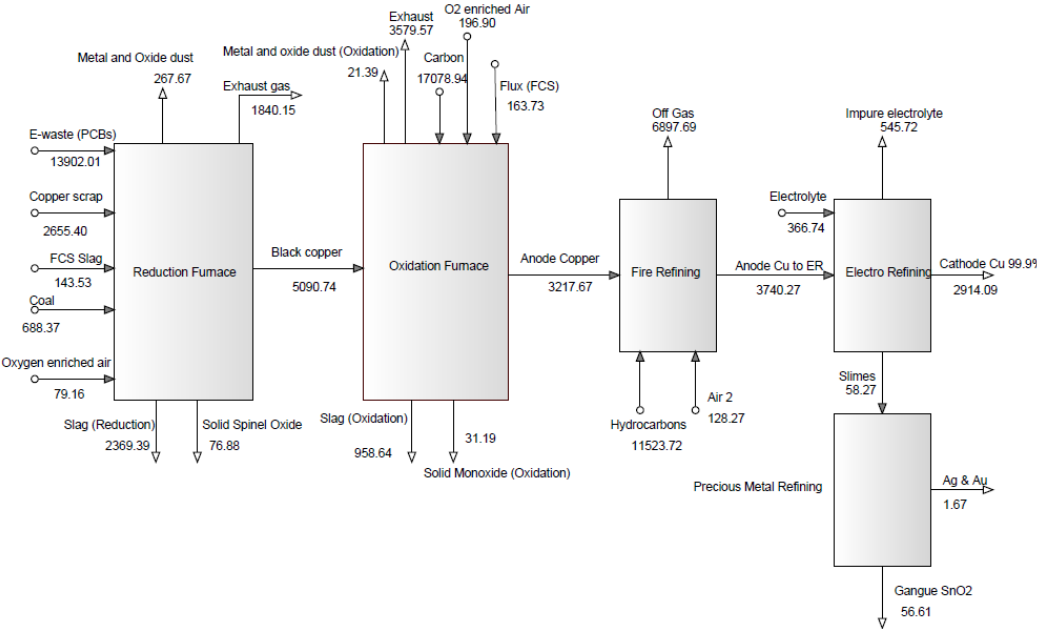
Figure 4. Total exergy balance (kWh), 50% e-waste in the throughput.